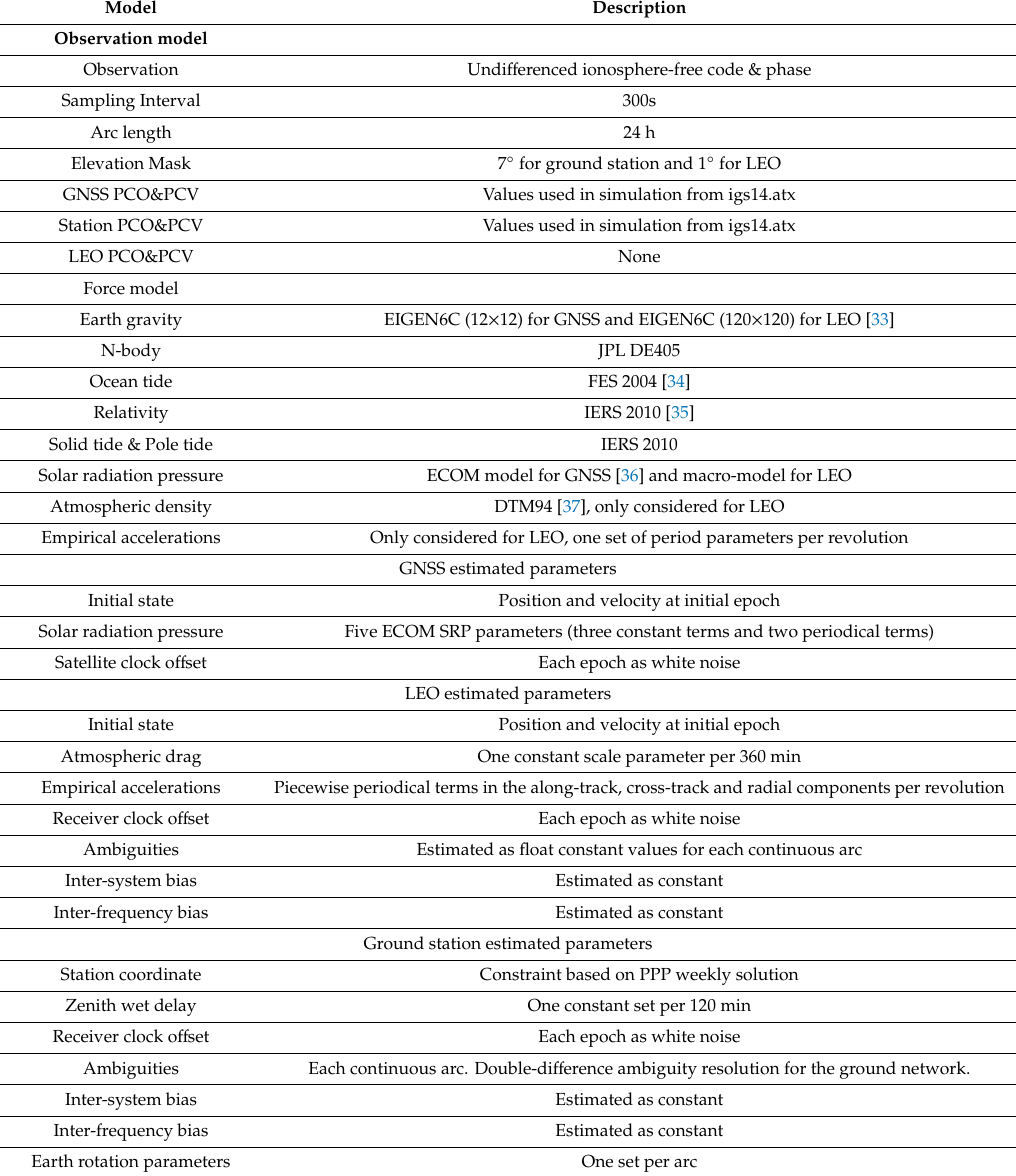
Table 3. Detailed processing strategy for the integrated multi-GNSS POD.